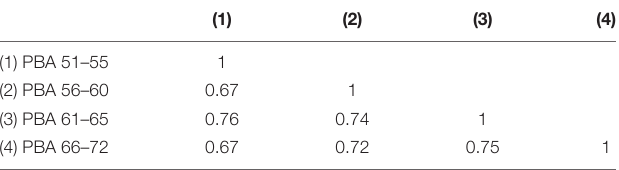
TABLE 1 | Predicted brain age (PBA) phenotypic polyserial correlations.